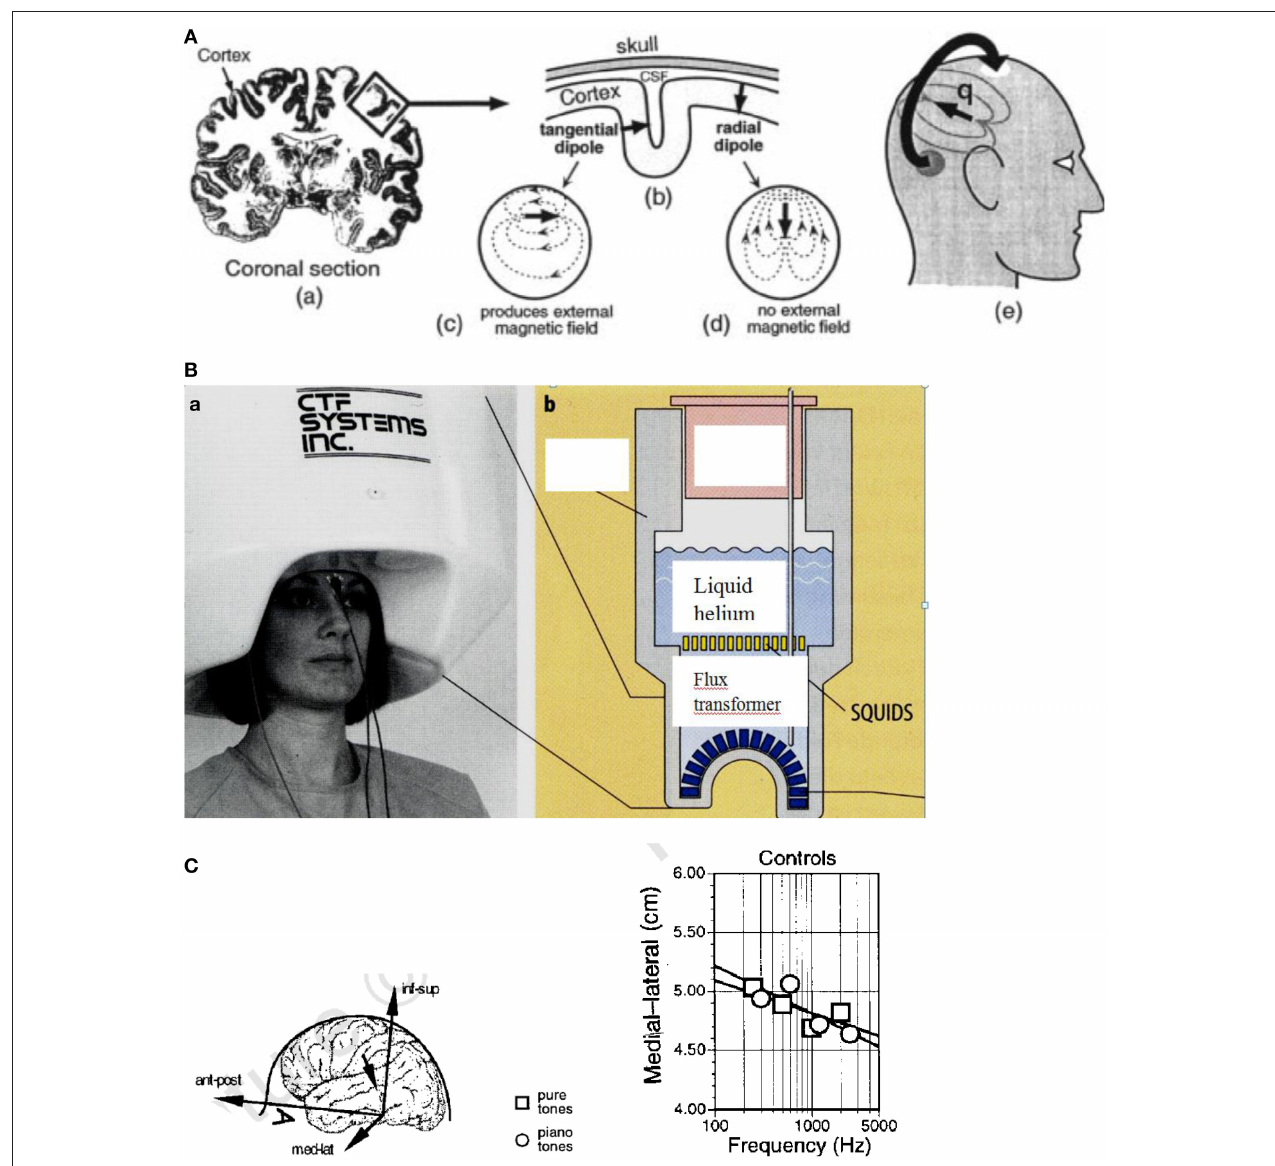
FIGURE 13 | (A) Origin of the MEG signal. (a) Coronal section of the human brain with the cortex in dark color. The electrical currents flow roughly perpendicular to the cortex. (b) In the convoluted cortex with the sulci and gyri the currents flow either radially or tangentially (c) or radially (d) in the head. (e) The magnetic fields generated by the tangential currents can be detected outside the head (Vrba and Robinson, 2001). Reprinted with permission from Vrba and Robinson (2001) © 2001 Elsevier. (B) (a) Magnetoencephalography facility containing 150 magnetic field sensors. (b) SQUIDs (superconducting quantum interference devices) and sensors immersed for cooling in liquid helium contained in a Dewar vessel (cross section) (Birbaumer and Schmidt, 2010). Reprinted with permission from Birbaumer and Schmidt (2010) © 2010 Springer. (C) Cortical stimulation by pure and piano tones . Left : Medial–lateral coordinates are shown for single equivalent current dipoles fitted to the field patterns evoked by pure sine tones and piano tones in control subjects. The inset defines the coordinate system of the head. Right : Equivalent current dipoles (ECD) shift toward the sagittal midline along the medial–lateral coordinate as a function of the frequency of the tone. Ant–post, anterior–posterior; med–lat, medial–lateral; inf–sup, inferior–superior (Pantev et al., 1998). Reprinted with permission from Pantev et al. (1998) © 2001 Nature Publishing